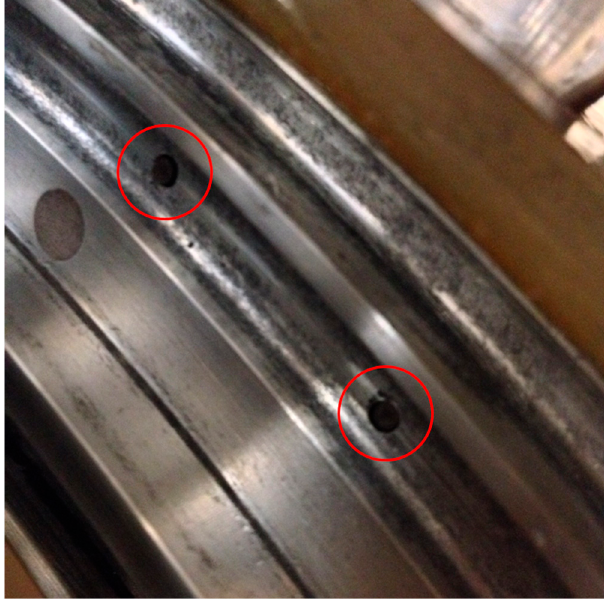
Figure 2. Rim seal cavity geometry and unsteady sensor location. NGV refers to nozzle guide vane.